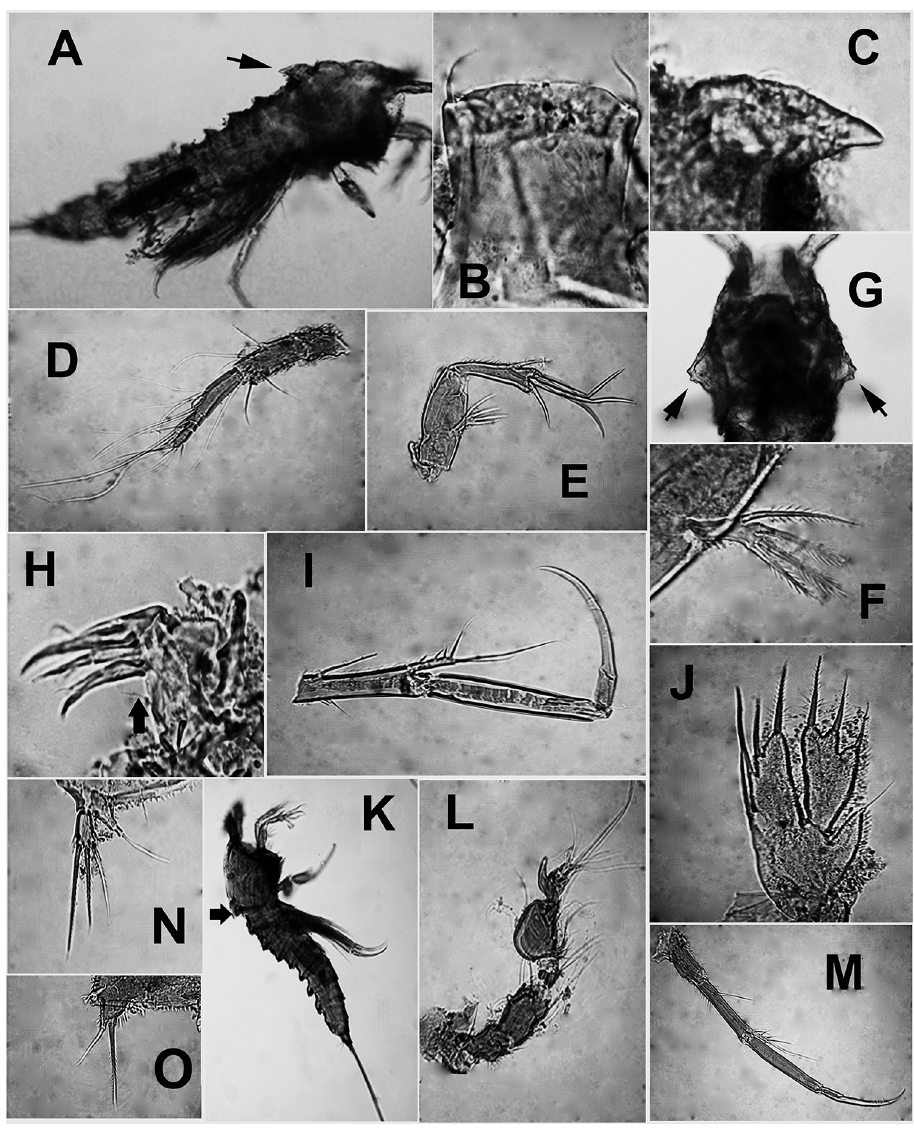
Figure 7. A–O Echinolaophonte armiger (Gurney) from Colombia, unscaled digital micrographs. Adult female (body length = 644 μm). A habitus, lateral view showing dorsal process on cephalic shield (arrow) B rostrum showing flat anterior surface and depressed distal margins C process on cephalic shield, lateral view D antennule E antenna F detail of antennary exopod G cephalosome showing weak development of posterolateral margins (arrows), dorsal view H maxillule showing slender inner seta on syncoxa (arrowed) I leg1 J leg 5; adult male (body length 560 μm) K habitus, lateral view showing smooth dorsal process on cephalosome L antennule M leg1 N leg 5 O leg